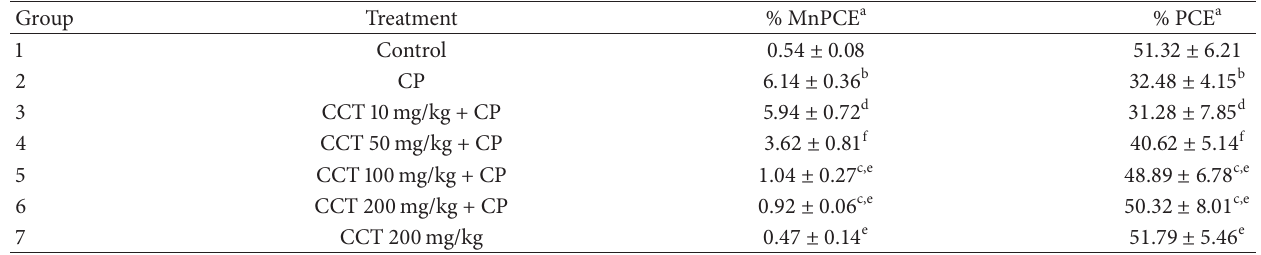
Table 1: Frequency of MnPCE and mitotic activity (% PCE) in bone marrow cells of mice treated with CCT fruits extract and/or CP. Group